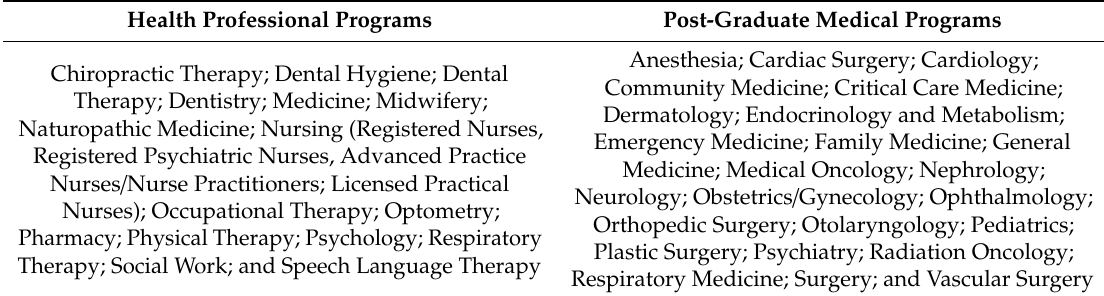
Table 1. Health professional program